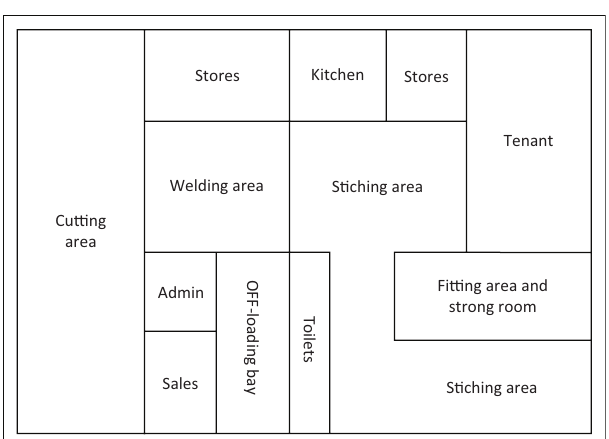
FIGURE 1-A1: Factory layout and primary activity